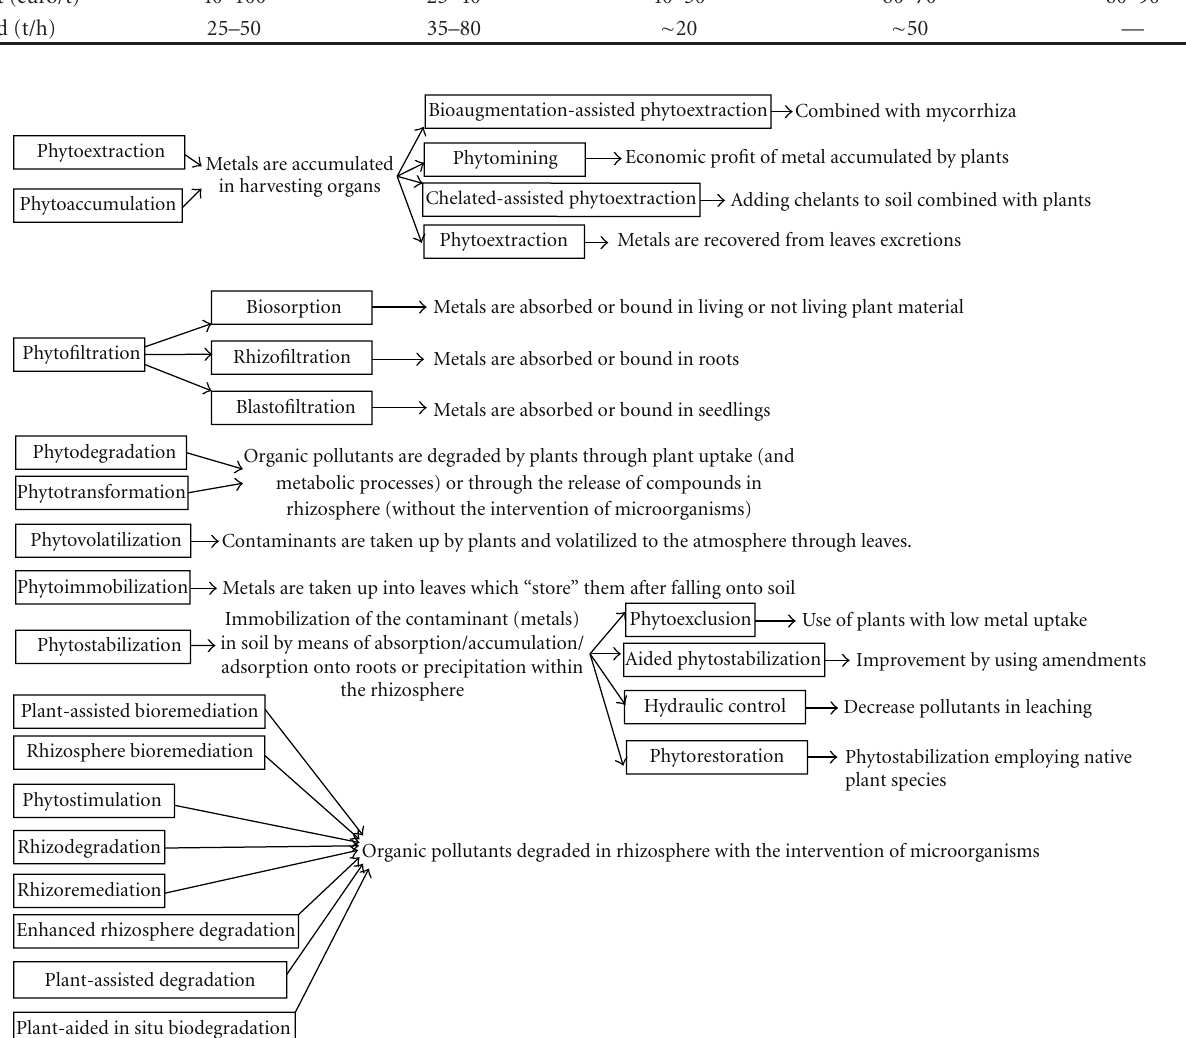
Figure 1: Current classification of most frequently used phytotechnologies for soil